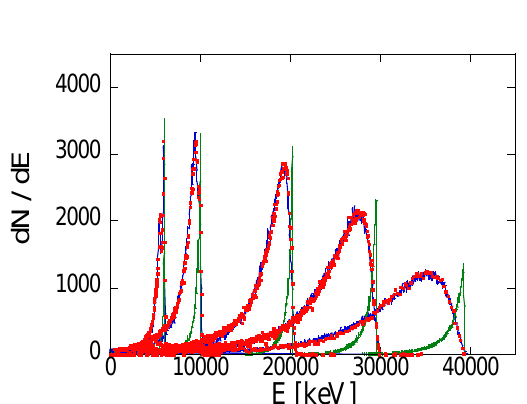
Figure 3. (Color online) Experimental response functions of a 3.5" 4.0" LaBr 3 (Ce) detector to LCS γ -ray beams (red dots), × the best-fit GEANT4 simulations (blue lines) and energy profiles of the incident LCS γ -ray beam (green lines).